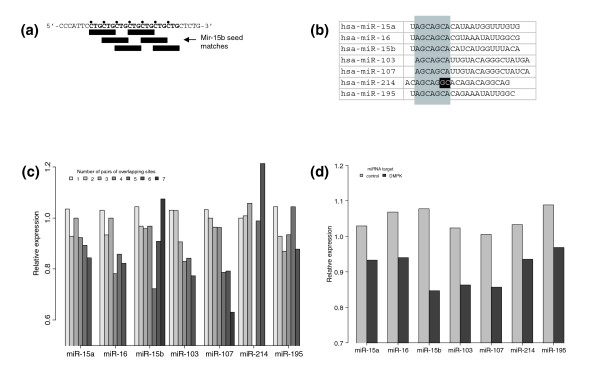
CTG repeat-binding miRNAs and their repression of pairs of extensively overlapping sites. (a) A diagram showing how a region of NM_173354 containing seven CTG repeats can result in six binding site seeds (CTGCTG) and five pairs of extensively overlapping sites (pairs of binding sites 3 bp apart). (b) Seven miRNAs containing CAG-rich seed regions that are predicted to bind to CTG repeats. Only hsa-miR-214 has mismatches in the seed region. (c) Number of overlapping binding sites versus relative expression for seven CTG repeat-binding miRNAs. In general, as the number of pairs of extensively overlapping sites increases, the degree of repression increases. In particular, mirs-107, -103, and -15a show a strong correlation. (d) Decreased relative expression of wild-type DMPK with respect to seven CTG repeat-binding miRNAs suggests repression of mutated DMPK by miRNAs could play a role in DM1. Targets with no overlapping pairs of sites served as control and showed no overall repression.